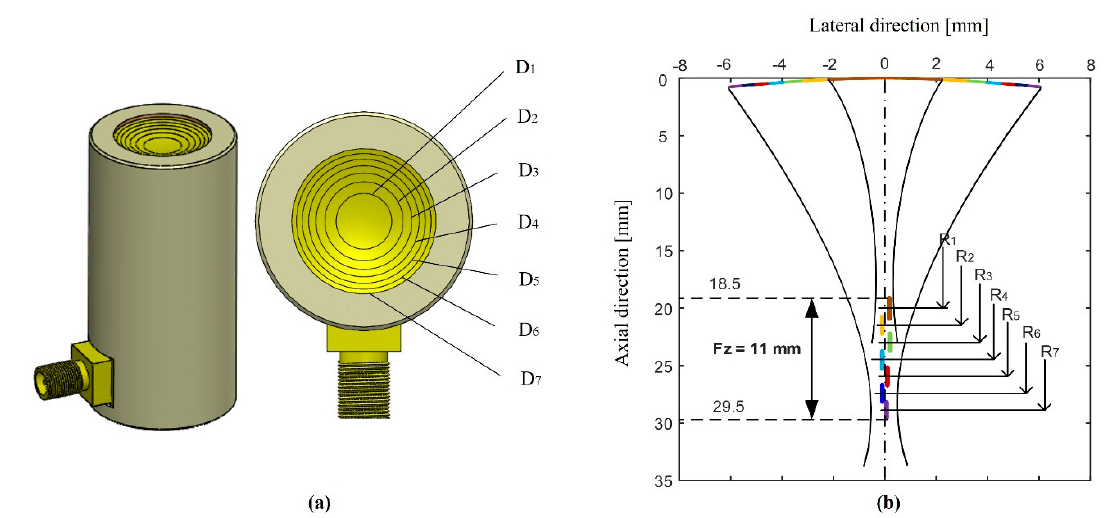
Figure 1. The ( a ) profile and ( b ) distribution of the focal zones of the multifocal point (MFP) Figure 1. The (a) profile and (b) distribution of the focal zones of the multifocal point (MFP) transducer.